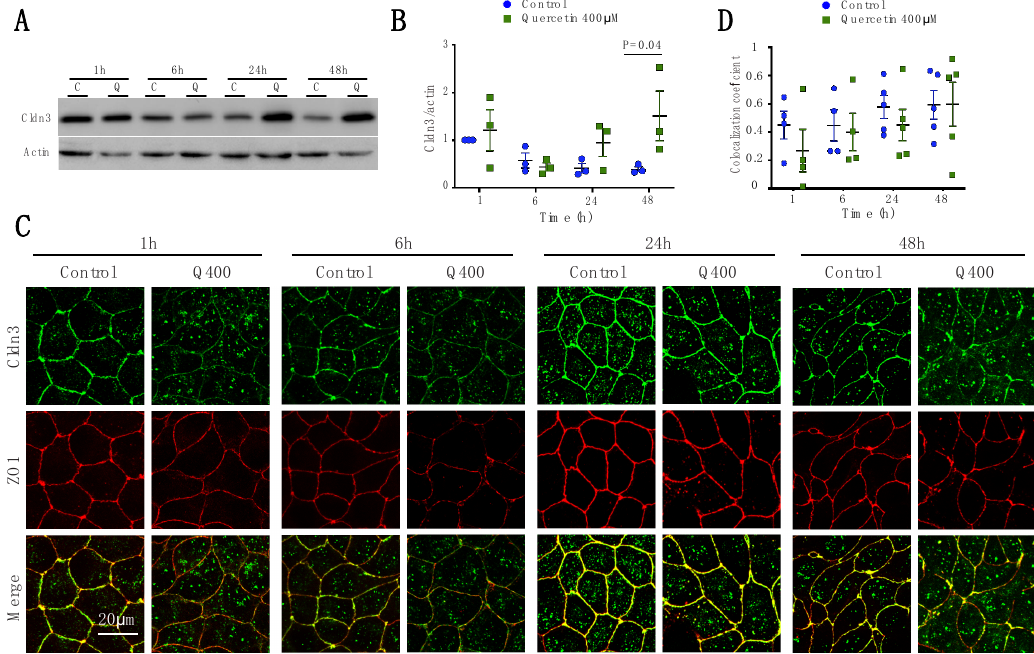
Figure 4. Analysis of Cldn3 expression and localization in MDCK II cells following quercetin treatment. ( A ) Western blot analysis of Cldn3 expression in cell lysates from control and 400 µM